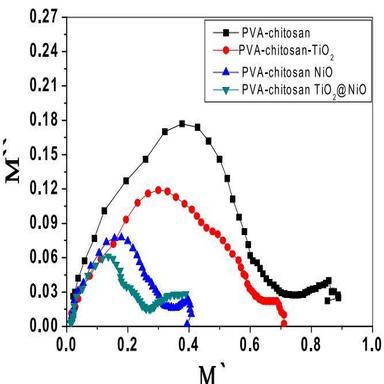
Cole‒Cole plot of PVA-chitosan–TiO2, PVA-chitosan–NiO, and PVAchitosan– TiO2@ NiO films.